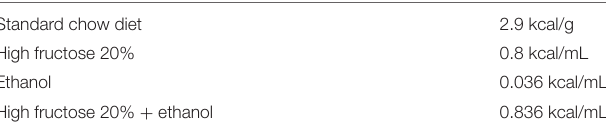
TABLE 1 | Caloric value for each substrate. Standard chow diet 2.9 kcal/g High fructose 20% 0.8 kcal/mL Ethanol 0.036 kcal/mL High fructose 20% + ethanol 0.836